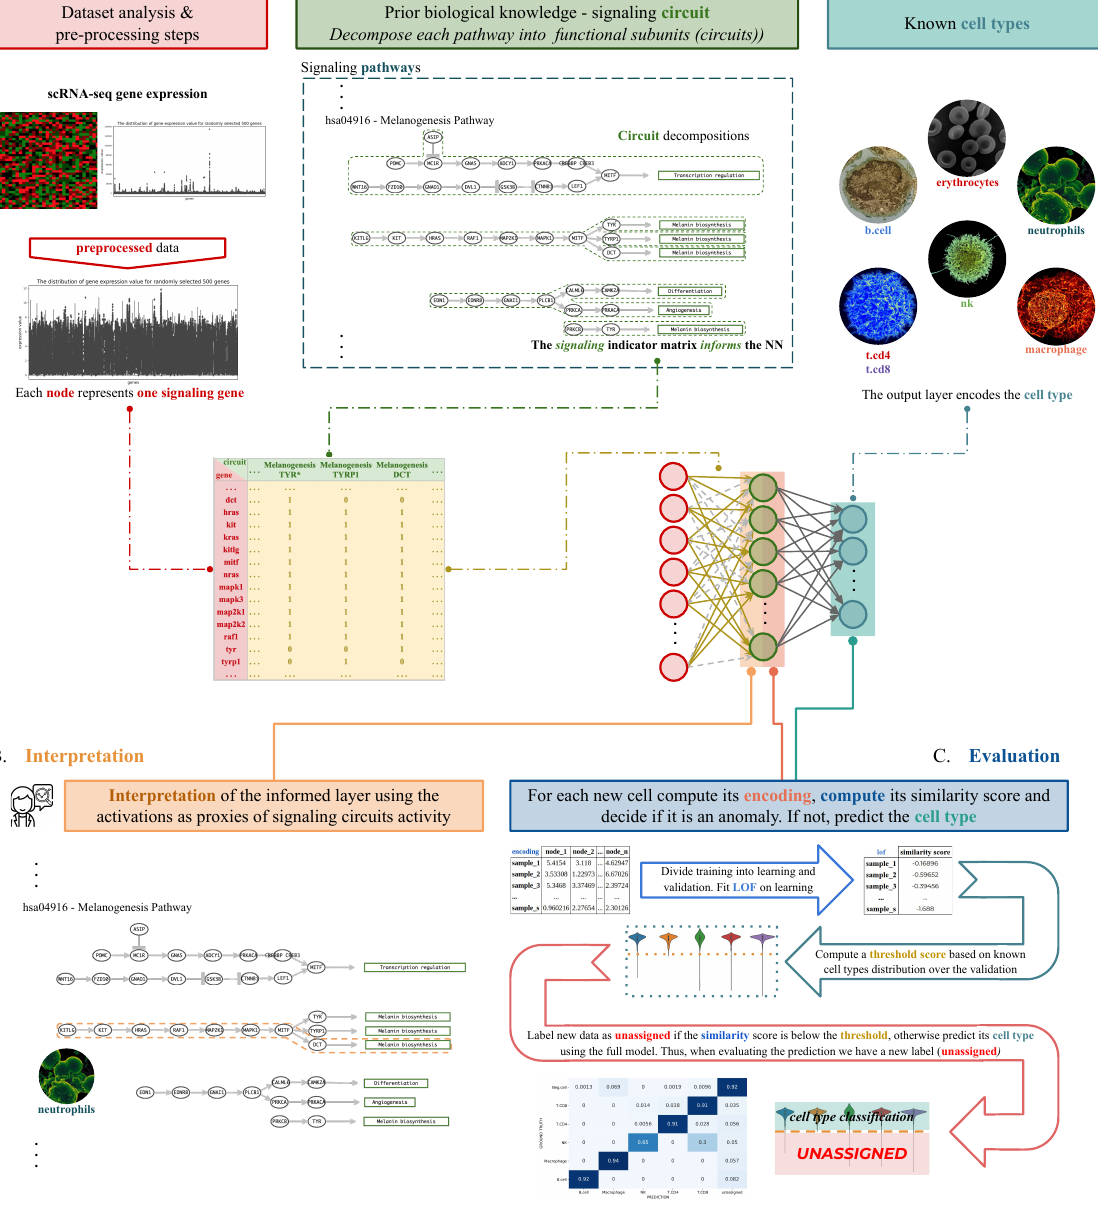
Figure 1. The first step ( A ) consists of preprocessing the data, building the signaling-informed layer S , and designing the architecture of the network based on the constraints imposed by an indicator matrix I S (see Methods). The second step ( B ) deals with the interpretation using the functional characterization of each cell cluster by aggregating the activations of the informed layer with respect to each observed or predicted cell type. The final step, ( C ) consists in making new predictions by (i) dividing the training set into learning and validation , (ii) fitting an anomaly detection algorithm to the encodings of the learning set, compute a threshold with validation , and (iii) label a new cell as unassigned if the threshold is not met, otherwise use the cell type prediction of the full